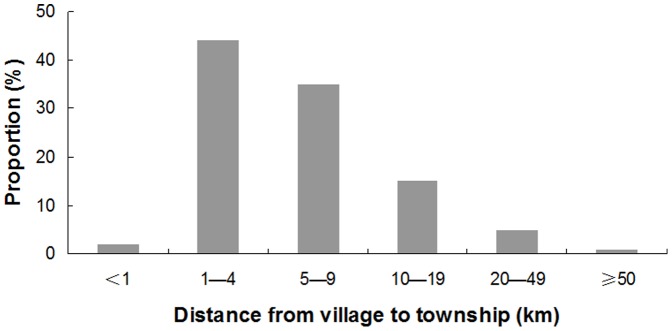
The distribution of distance from village to township.